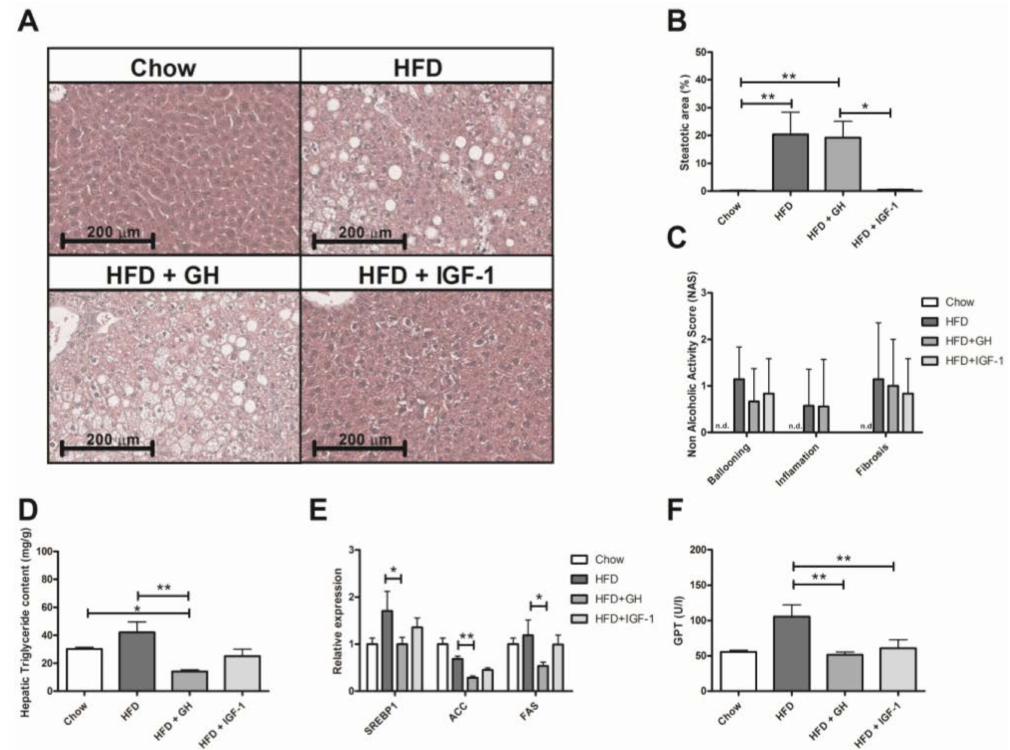
Figure 2. Effects of somatotropic hormone supplementation in liver. ( A ) Representative histological images of livers from experimental groups after 22 weeks of feeding with either chow, high fat diet (HFD) and HFD supplemented with growth hormone GH or insulin-like growth factor-1 (IGF-1). ( B ) Quantification of liver steatosis by histology in percentage of steatotic hepatocytes in experimental groups. No significant increase in steatosis can be observed in HFD + IGF-1 group compared to Chow. ( C ) Histology Score. No significant changes were observed in liver inflammation, ballooning and fibrosis in histology. ( D ) Hepatic triglycerides content according to experimental groups. A significant reduction of triglycerides content was observed in HFD + GH group. ( E ) Effects of hormone supplementation in lipogenic gene expression. A significant reduction was observed in HFD + GH group compared to HFD. ( F ) Serum ALT levels according to experimental groups. A significant reduction was observed in HFD + GH and HFD + IGF-1 groups compared to HFD. * p < 0.05; ** p <